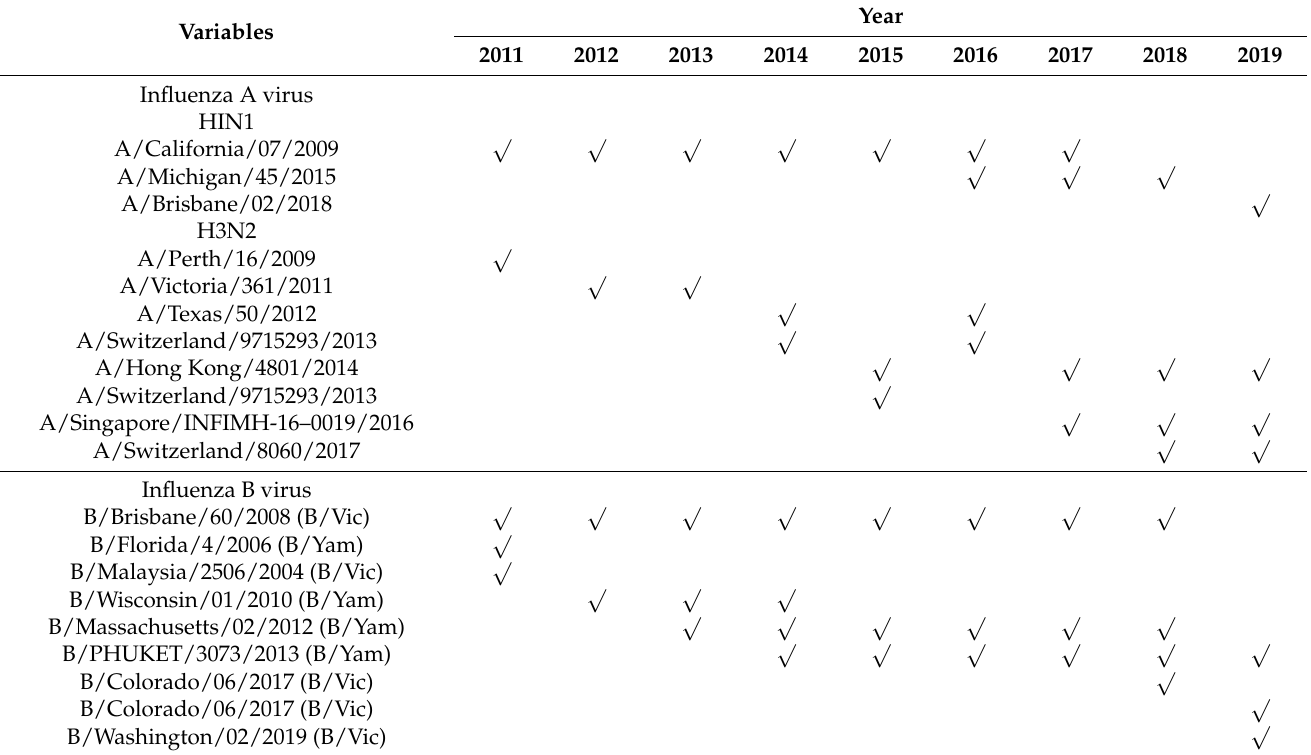
Table 5. The categorization of isolated influenza virus strains by gene sequencing in Taiwan during 2011 and 2019.